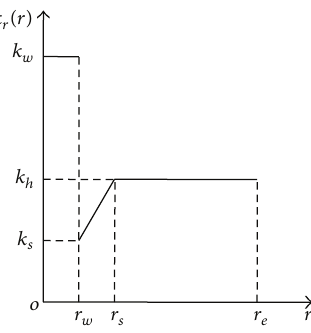
Figure 3: Five variation patterns of horizontal permeability coeffi- cient in smear